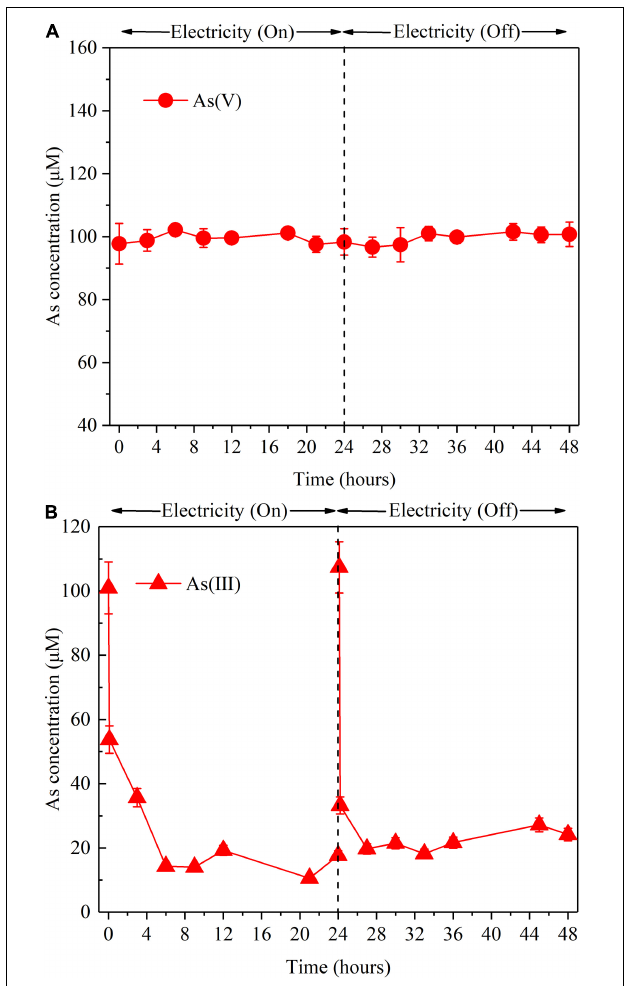
FIGURE 4 | Effect of S(–II) on As removal in the abiotic control reactor with the influent containing As(V) (A) and containing As(III) (B) with applied I cell or not, respectively. Experimental conditions: influent [As(V)] = 100 µ M, [As(III)] = 100 µ M, (Na 2 S) = 3.3 mM, I cell = 30 mA. “On” indicates I cell was applied; “Off” indicates the I cell was absent. The error bars show the standard deviation ( n = 3).